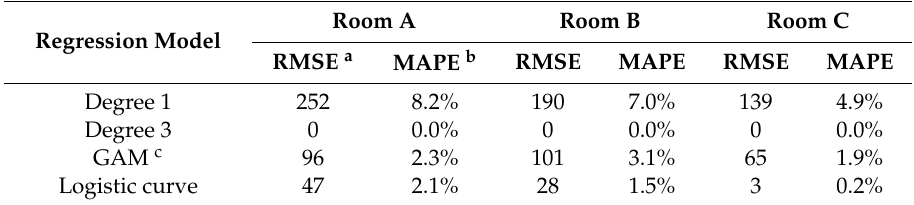
Figure 2. Comparison of regression model (degree 1, degree 3, generalized additive model (GAM), and logistic curve) results for ventilation volume according to operation rate ( η ) in place in ( a ) Room A, ( b ) Room B, and ( c ) Room C. Table 3. Comparison of RMSE and MAPE of the four regression models (degree 1, degree 3, GAM, and logistic curve) for Rooms A to